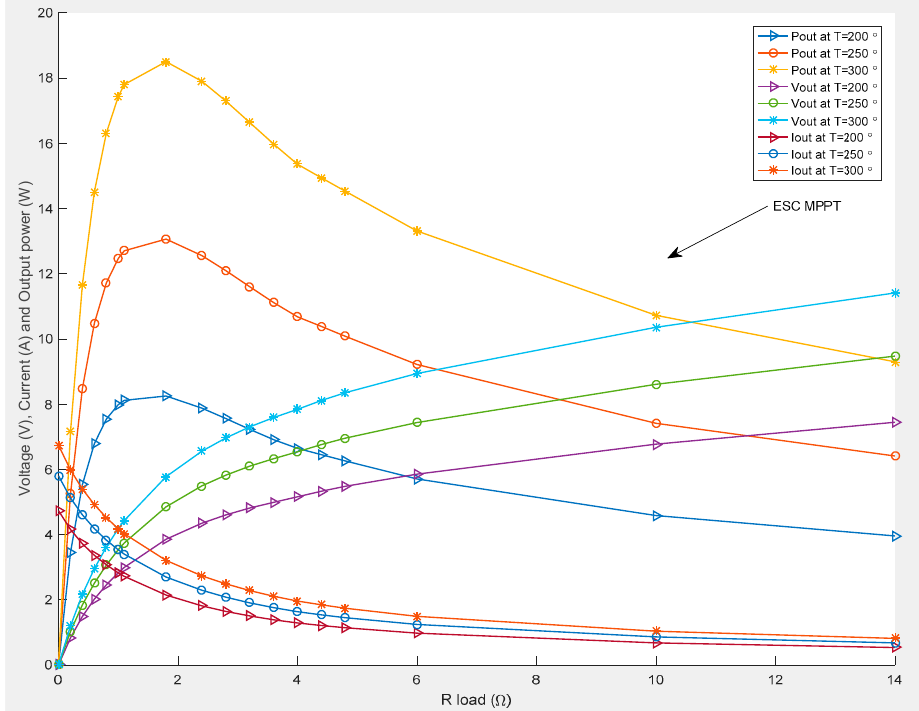
Figure 13. The voltage, current and output power of ESC MPPT model for a single TEG.